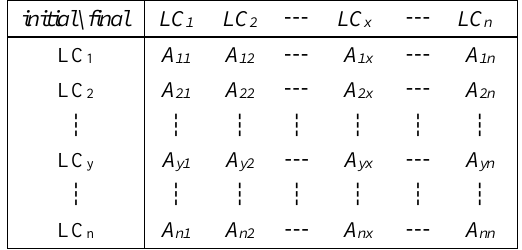
Table1. The association table between indicators and variables